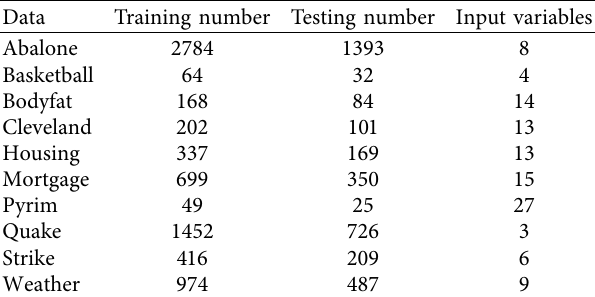
Table 11: Details of data